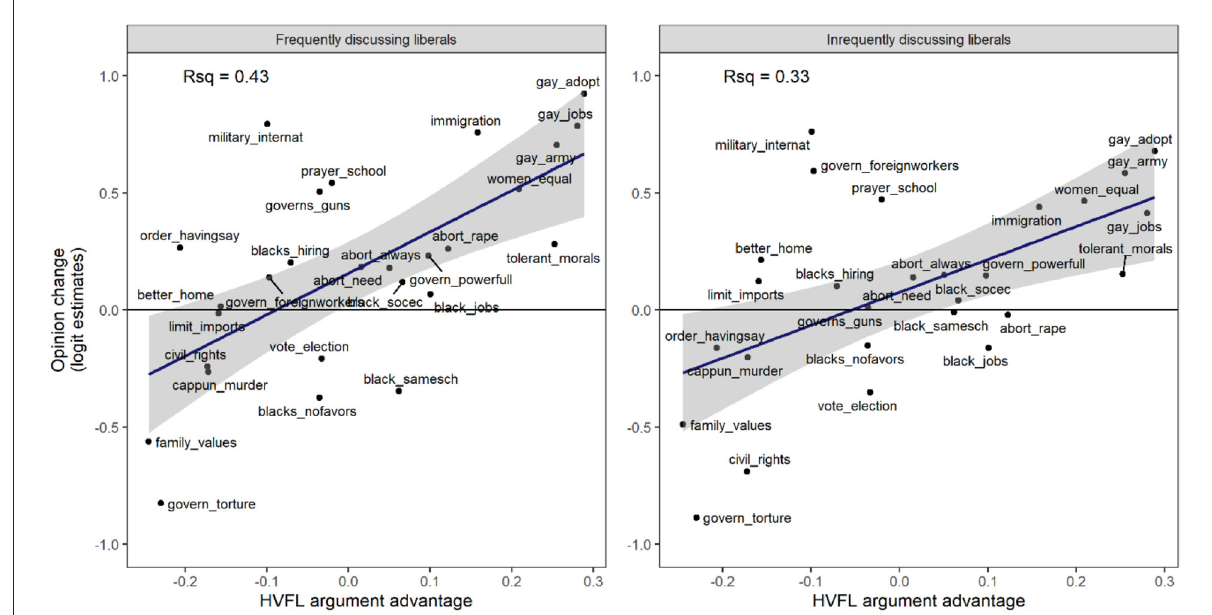
FIGURE5 The effect of HVFL argument advantage on opinion change over time in the American National Election Studies is greater among frequently discussing liberals (left) than among infrequently discussing liberals (right). The y-axis represents estimated opinion change in log odds per 10 years. The x-axis represents the HVFL argument advantage of the opinion stated in the